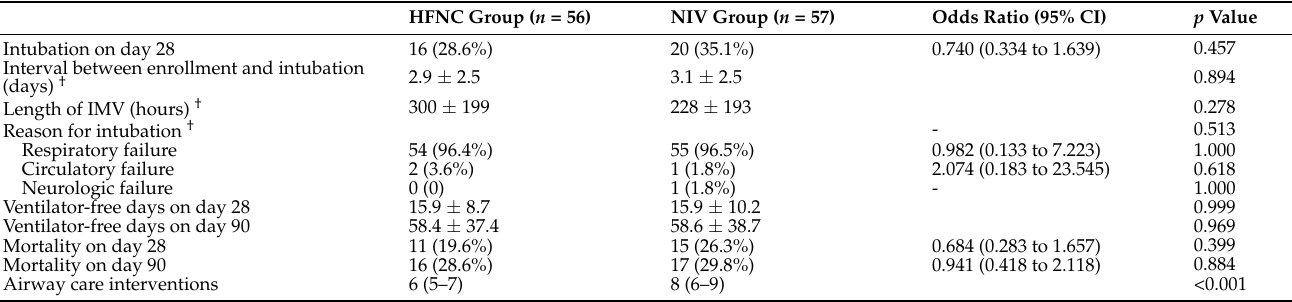
Table 3. Outcomes and cause analyses of enrolled AIDS